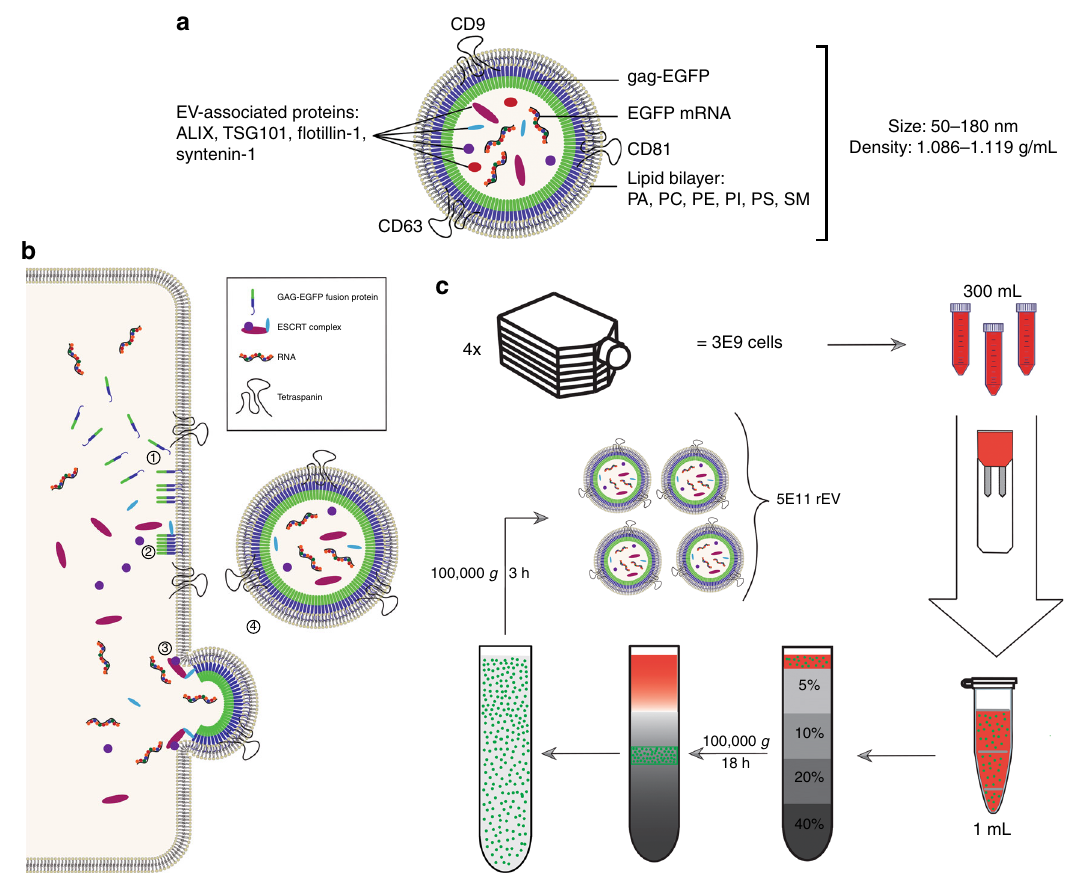
Fig. 1 rEV are separated from conditioned medium using density gradient centrifugation. a Schematic representation of rEV showing representative molecular components shared with sample EV, PA phosphatidic acid, PC phosphatidylcholine, PE phosphatidylethanolamine, PI phosphatidylinositol, PS phosphatidylserine, SM sphingomyelin. b Schematic overview of the production of rEV at the cellular level: (1) The gag-EGFP fusion protein inserts in regions of the plasma membrane enriched for tetraspanins CD9, CD63 and CD81 via its N-terminal MA domain containing a myristoyl group. (2) The gag- EGFP fusion protein oligomerizes and recruits ESCRT-1 proteins (TSG101) via the PTAP motive on its p6 domain. (3) Recruitment of ESCRT-2/3 proteins initiates the outward budding of the gag-EGFP containing plasma membrane. (4) ESCRT-3 mediated scission of the membranes fi nally causes release of rEV into the conditioned medium (CM) 13 . c Schematic overview of the work fl ow to separate rEV from CM of gag-EGFP transfected HEK293T cells. Seventy-two hour post transfection CM is collected from ~3 x 10 9 cells and concentrated to 1 mL. Concentrated CM is loaded on top of an OptiPrep density gradient (ODG) and centrifuged for 18 h at 100,000 × g . Density fractions of 1.086 – 1.119 g/mL are collected and pelleted for 3 h at 100,000 × g resulting